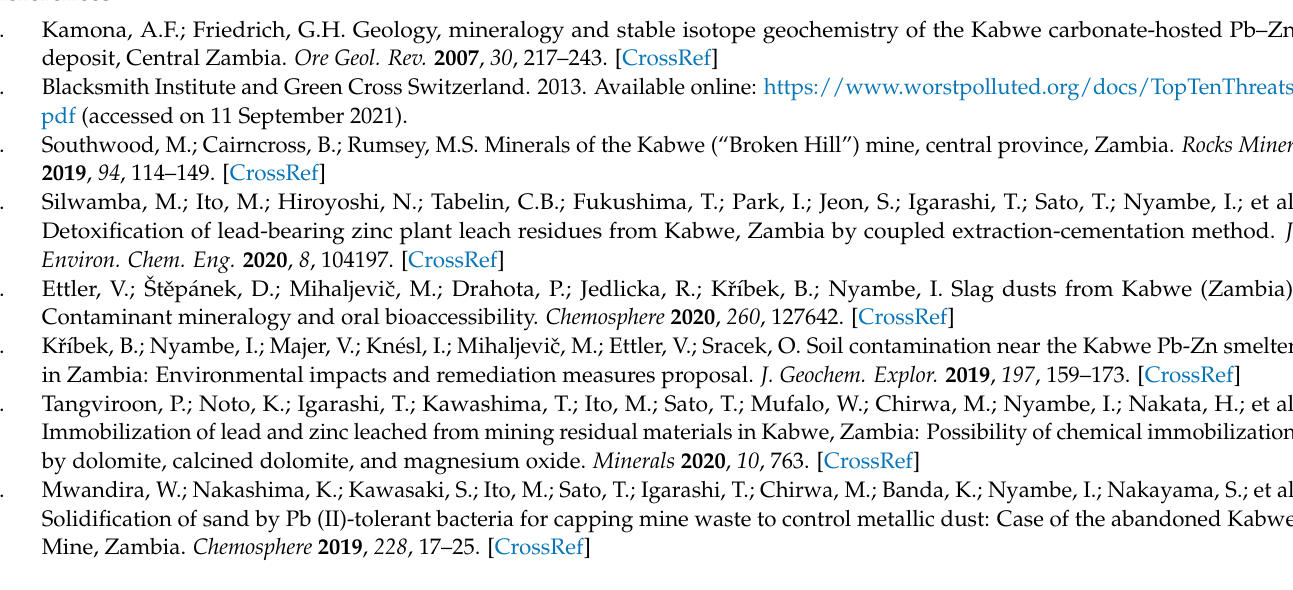
Table S7: Saturation indices ( SI ) of selected mineral phases controlling the release and retention of Pb and Zn in the selected SPs. Table S8: Leachate characteristics of the SPs, including other dissolved